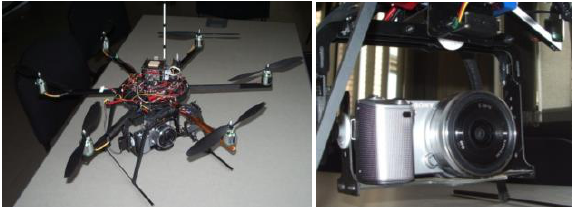
Figure 1 First version of Microkopter hexacopter (left); on board camera (right).